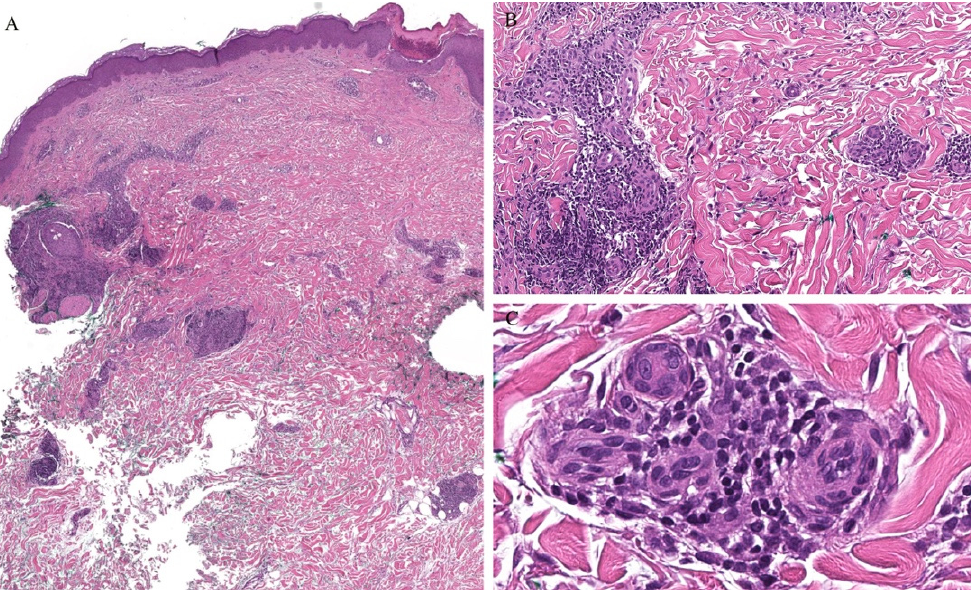
Figure 11. ( A – C ) Histopathology of syringotropic mycosis